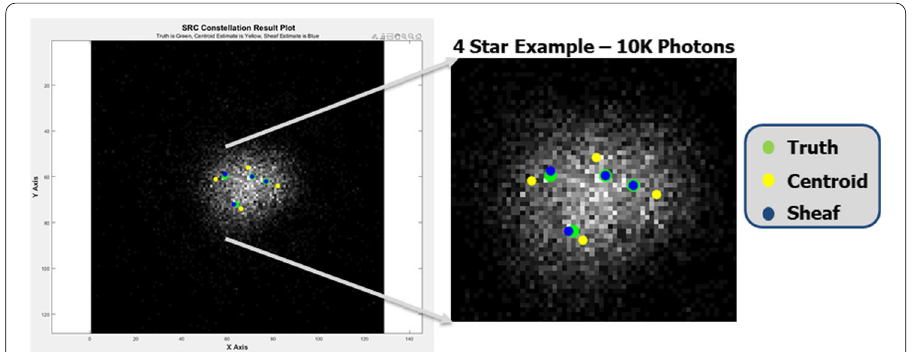
Fig. 3 A typical photon count distribution with 10000 photons (left) and (right), marked with the true star locations (green), a decomposition into four centroids (yellow), and the minimizer of consistency radius produced by our algorithm (blue)